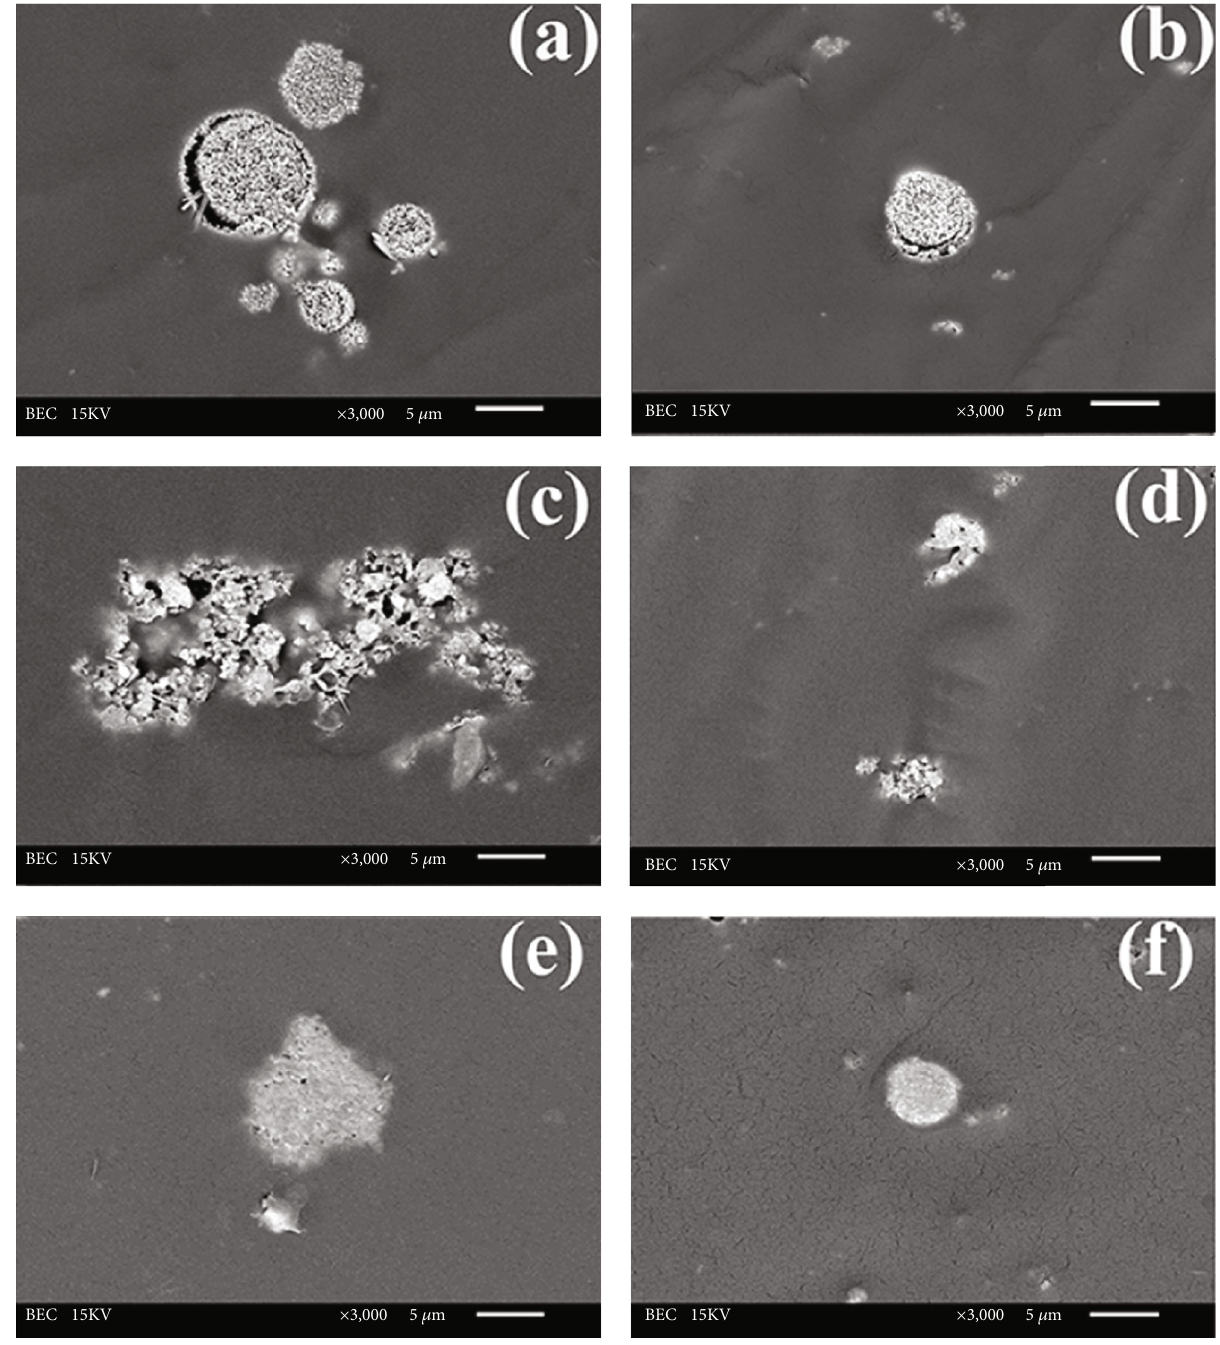
Figure 10: Backscattered electron SEM images of polymer composite fi lms containing di ff erent types and concentrations of VO (a) acrylic/VO (1.0 wt%), (b) acrylic/VO (1.5 wt%), (c) acrylic/VO 2 2 (1.5 wt%), (e) acrylic/VO @PSS:PEDOT-24 (1.0 wt%), and (f) acrylic/VO 2